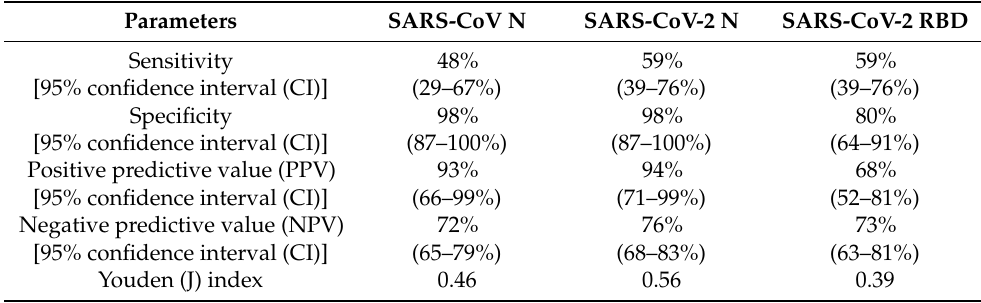
Table 2. Test performance characteristics of immunofluorescence of the three primary